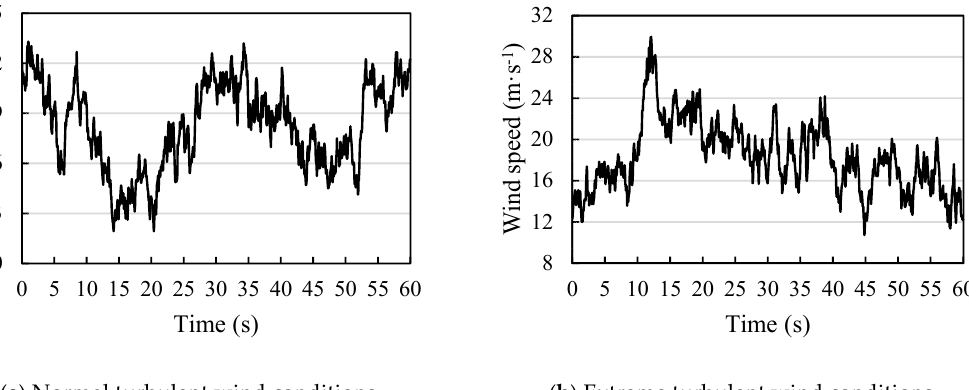
Figure 6. Longitudinal wind speed.